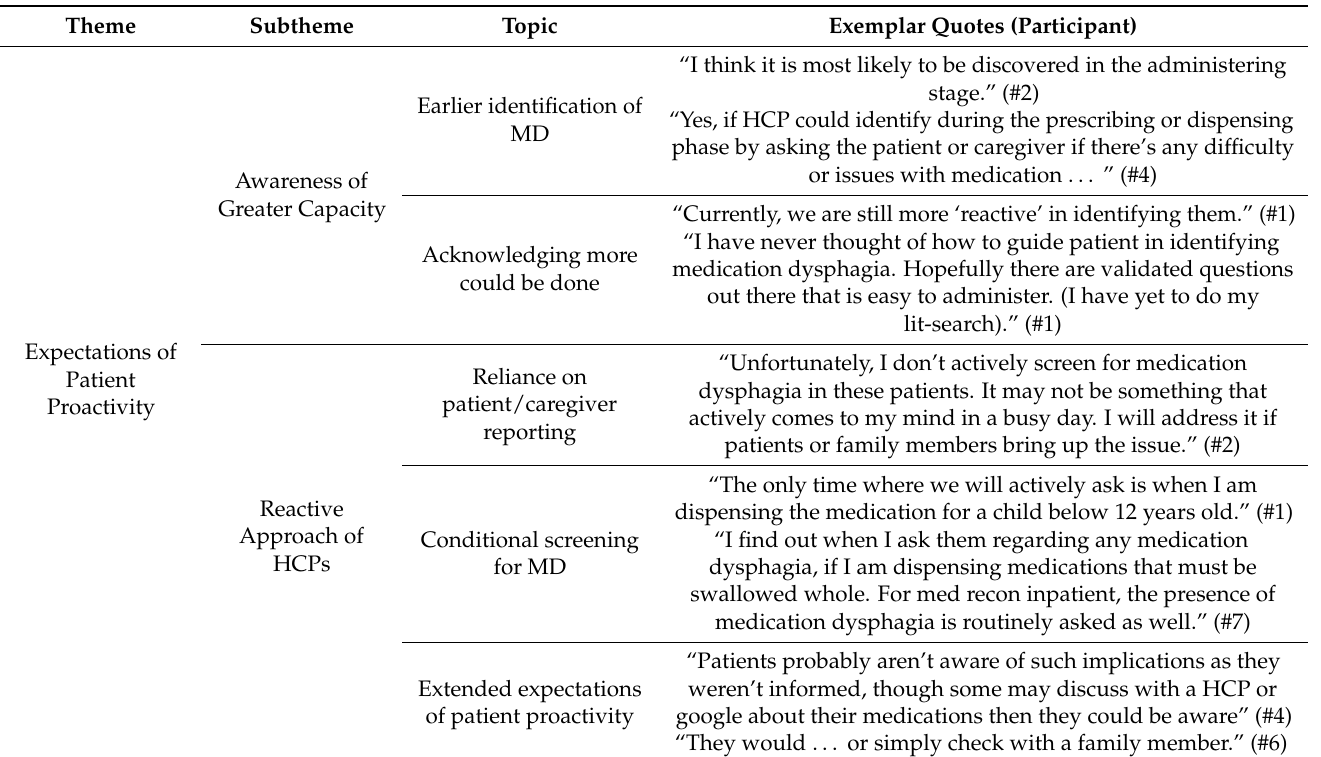
Table 4. Major theme of expectations of patient proactivity, corresponding subthemes, and exemplar quotes.